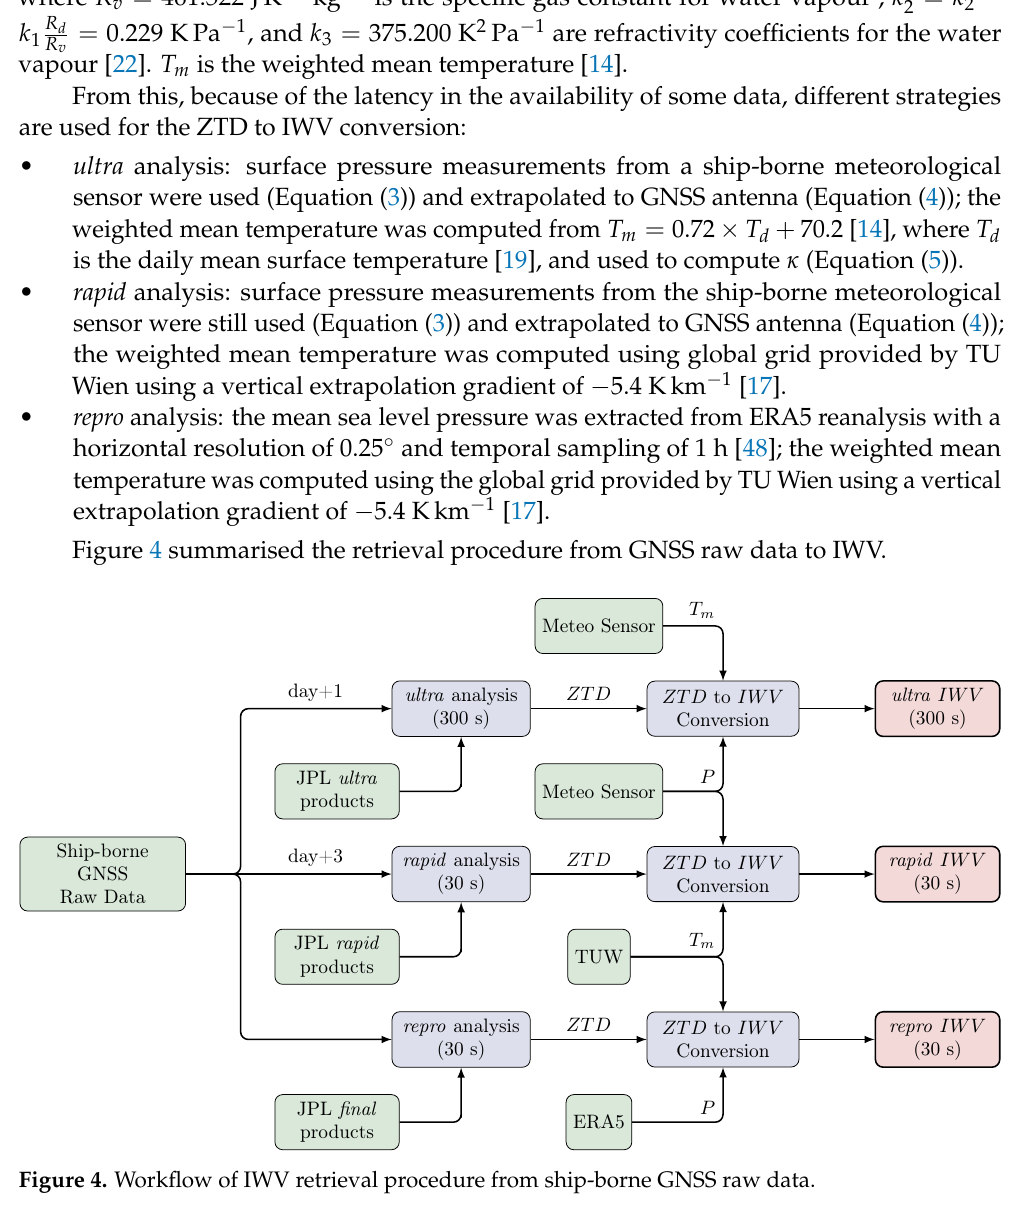
Figure 4. Workflow of IWV retrieval procedure from ship-borne GNSS raw